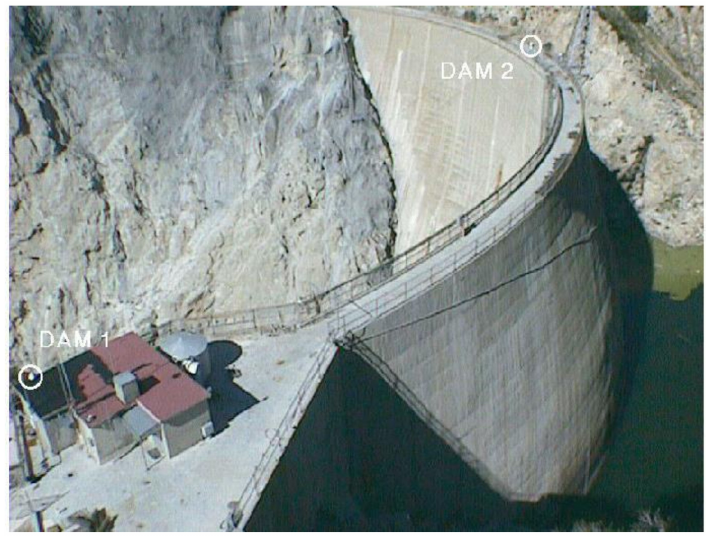
Figure 2. Example of the GNSS (Global Navigation Satellite System) continuous recording stations DAM1 (reference) and DAM2 (CP) at Pacoima dam, USA (image credit: J.A Behr, 1998,